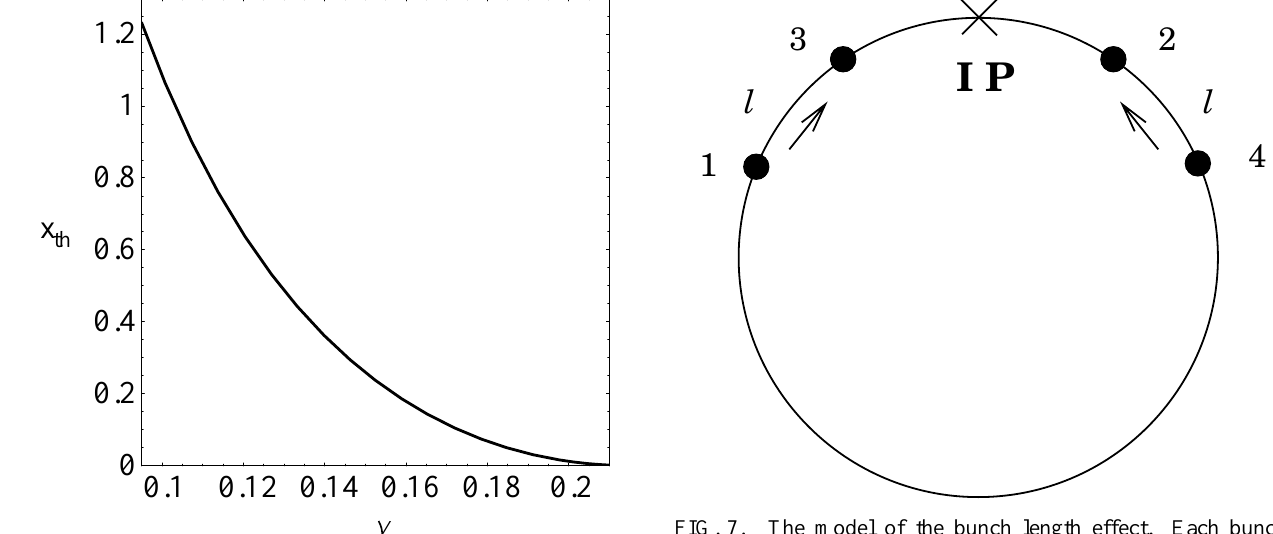
FIG. 7. The model of the bunch length effect. Each bunch consists of two particles with constant distance l between them. interaction with 4,